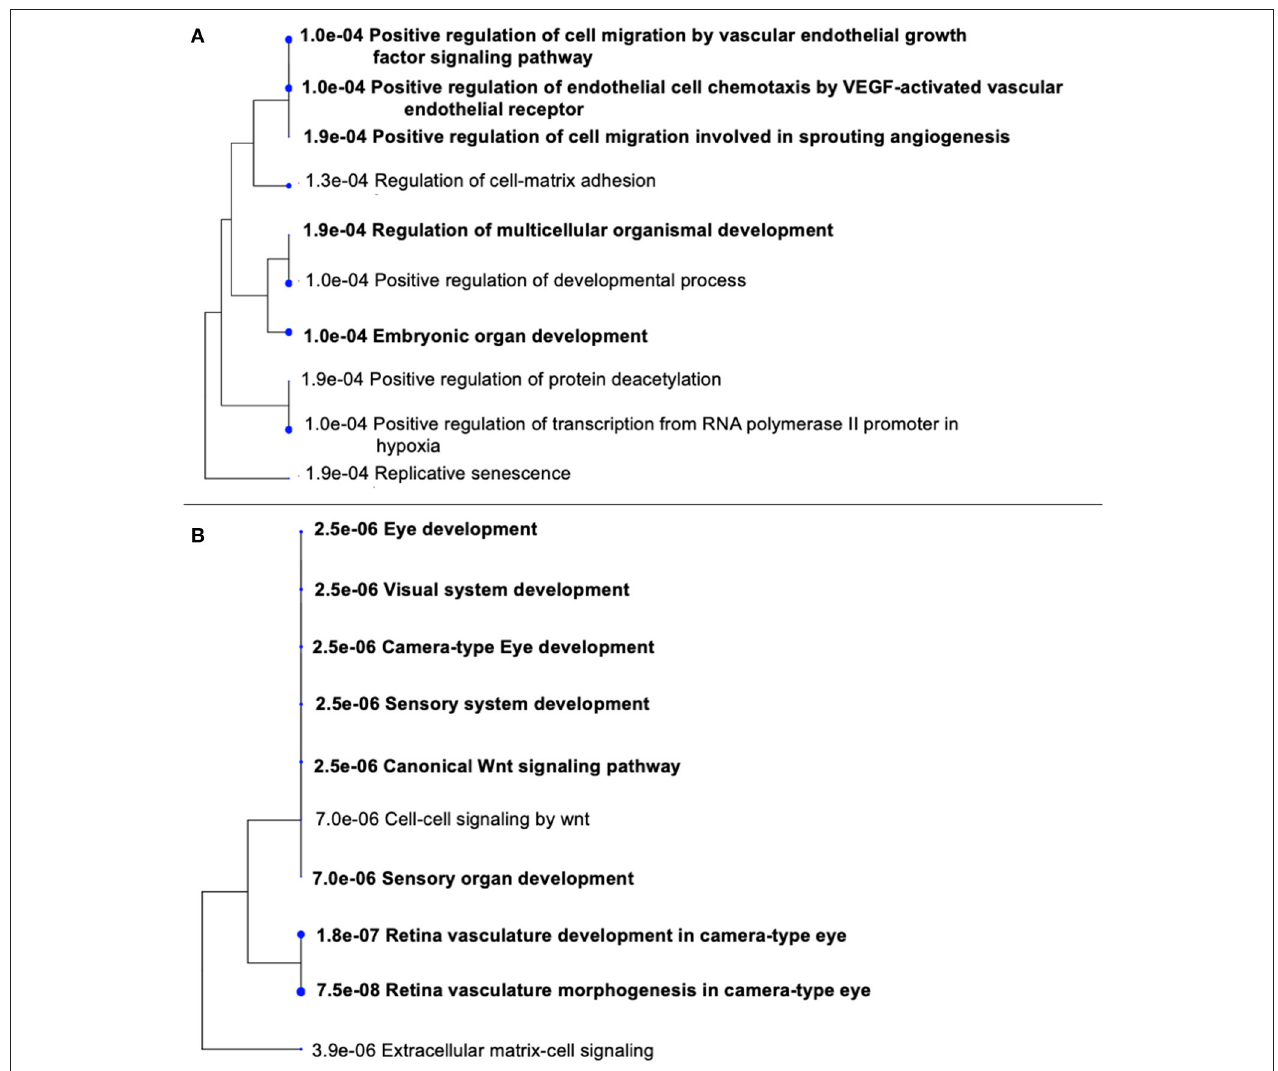
FIGURE 6 | Gene Ontology (GO) terms in the three modules. (A) Significantly enriched GO terms in module 1. (B) Significantly enriched GO terms in module 2. The functional and pathway enrichment analyses in PHPV were related with high score ( P > 0.005) based on a tree illustration created using the ShinyGo web server.